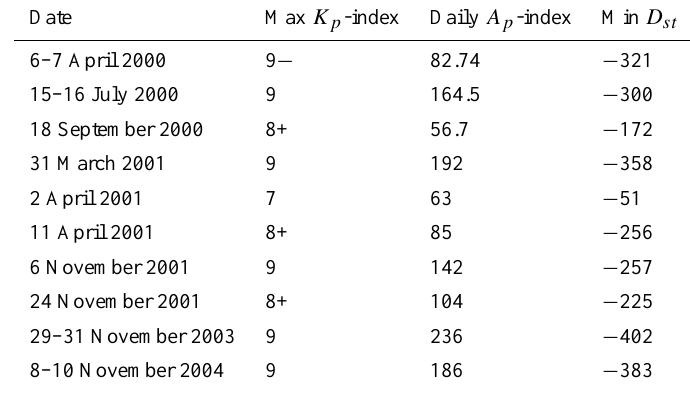
Table 1. Periods of railway failures and characteristics of the geomagnetic conditions at that time.